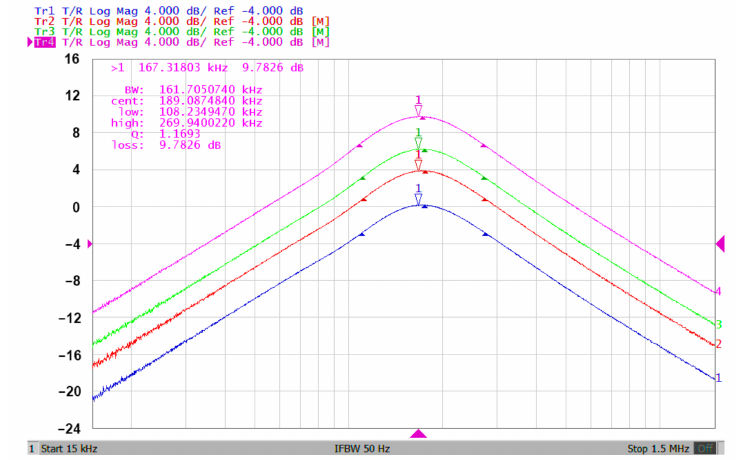
Figure 8. The measured magnitude responses of the V BP2 when g m2 was varied.